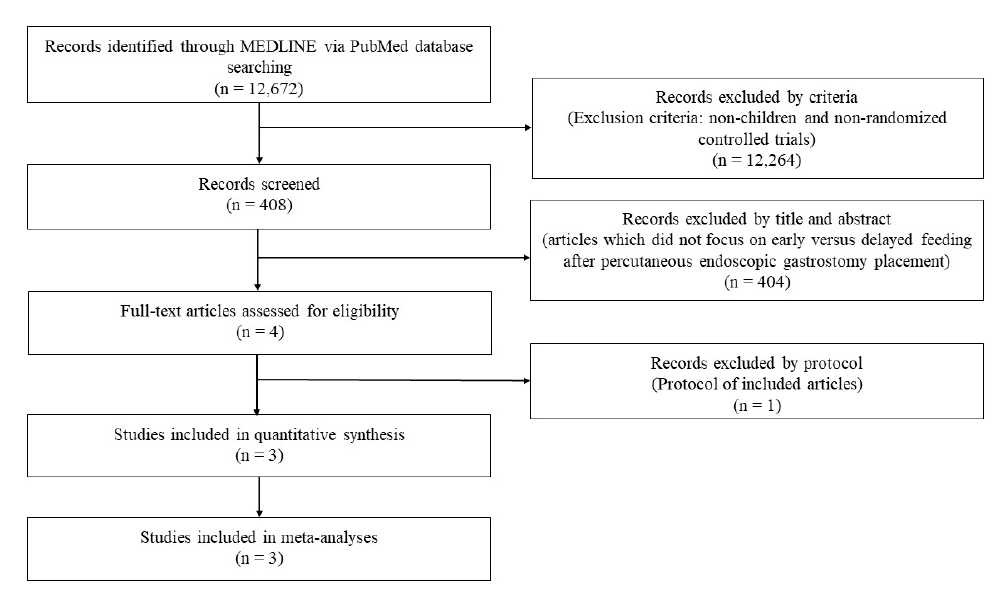
Figure 1. Flow chart of article selection.